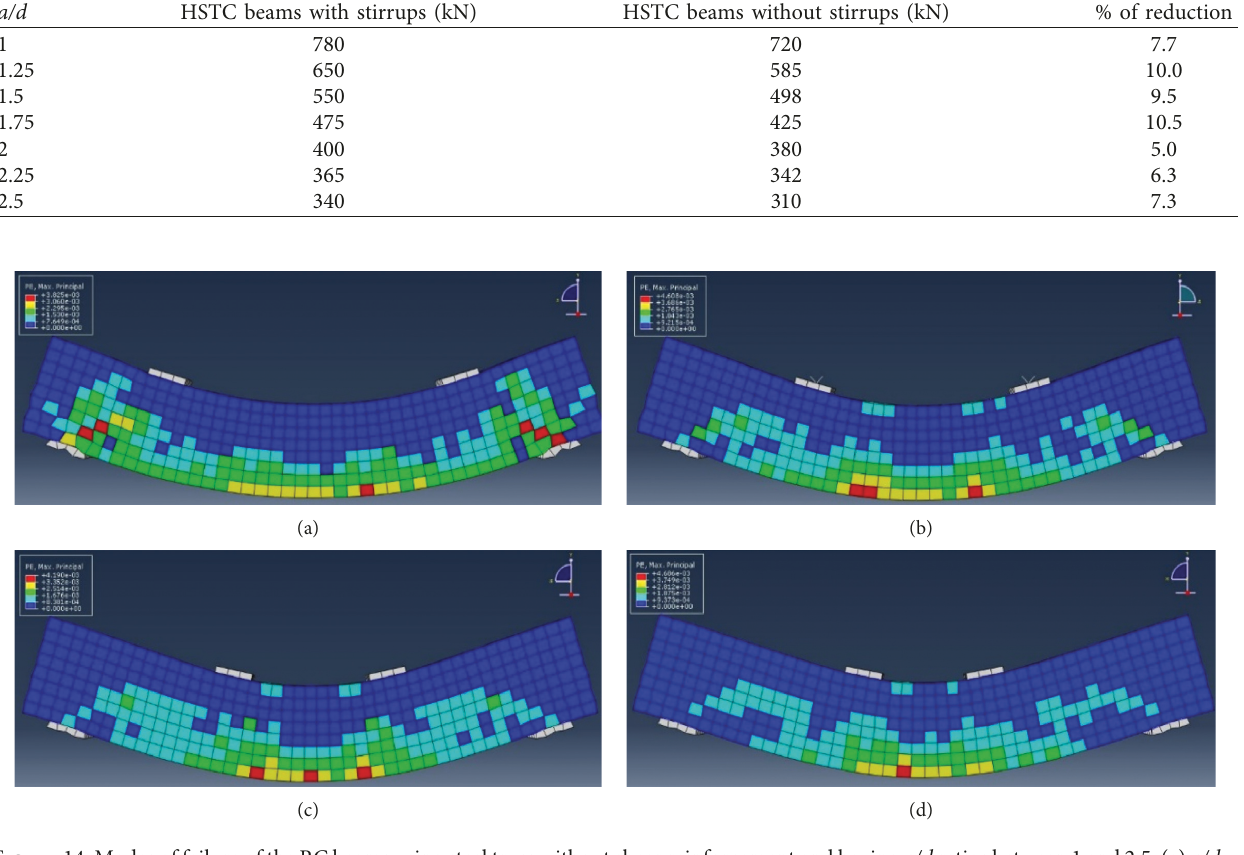
Figure 14: Modes of failure of the RC beams using steel truss without shear reinforcement and having a/d ratios between 1 and 2.5. (a) a/d � 1. (b) a/d � 1.5. (c) a/d � 2. (d) a/d �